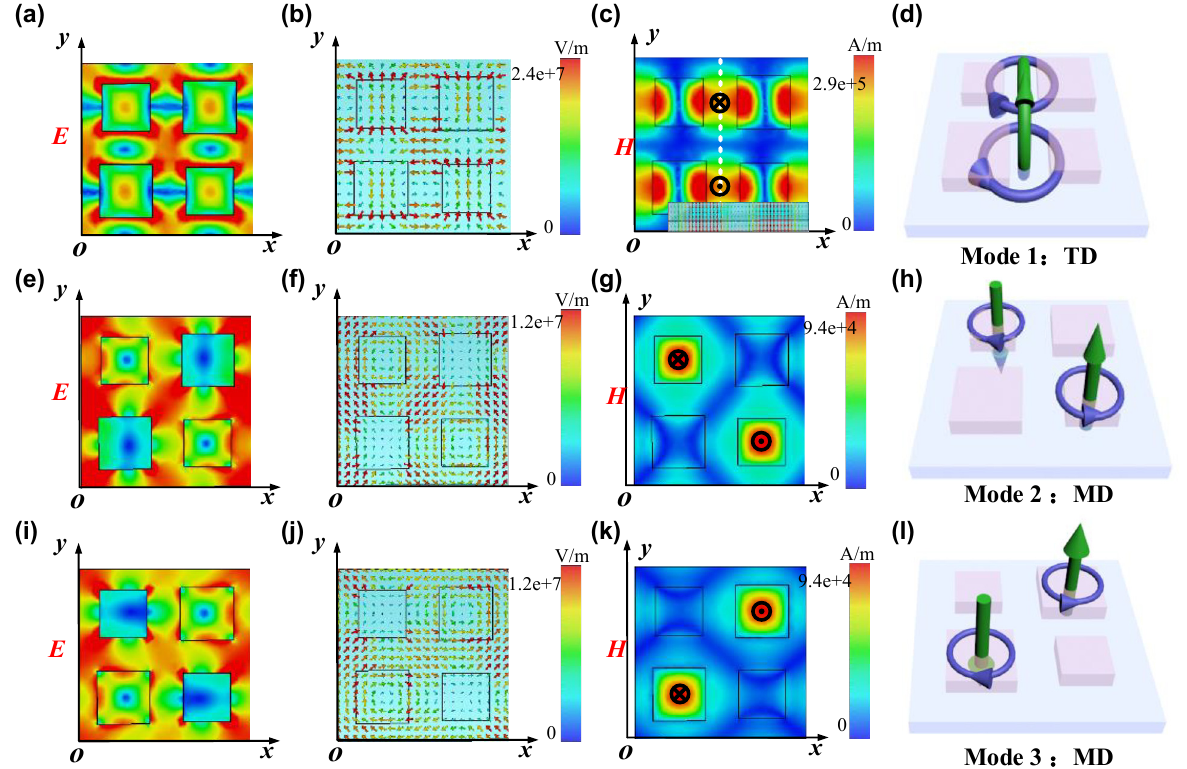
Figure 9: Electromagnetic field distributions and resonance modes. (a), (b), (c), and (d) are electric field, electric field vector, magnetic field profiles, and 3D schematic diagram of TD of Mode 1. (e), (f), (g), and (h) are electric field, electric field vector, magnetic field profiles, and 3D schematic diagram of TD of Mode 2. (i), (j), (k), and (l) are electric field, electric field vector, magnetic field profiles, and 3D schematic diagram of TD of Mode 3.